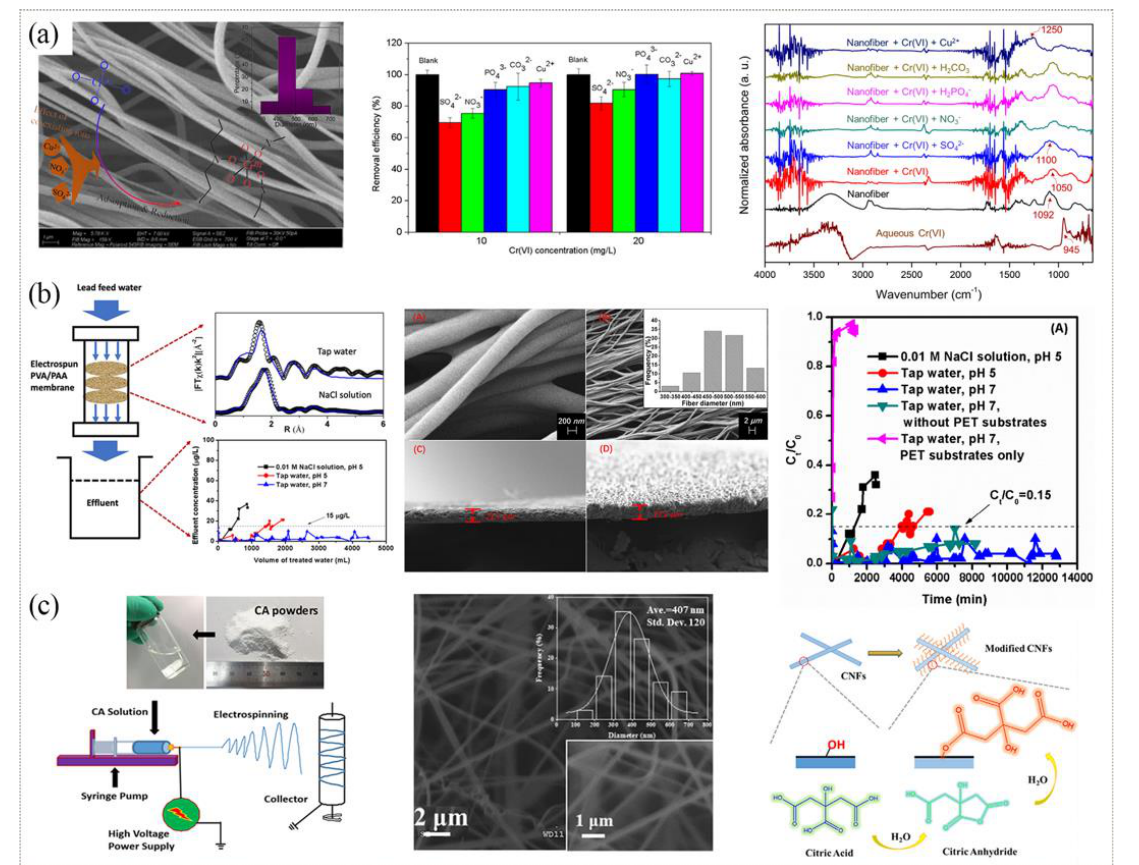
Figure 10. Preparation process, microstructure, and properties of heavy metal ion adsorption mem- branes: ( a ) PVA/PEI membrane. Reprinted with permission from Ref. [141]. Copyright 2020 Elsevier Ltd. ( b ) PVA/PAA membrane. Reprinted with permission from Ref. [143]. Copyright 2019 Elsevier Ltd. ( c ) Citric acid-incorporated CNFs membrane. Reprinted with permission from Ref. [145]. Cop-